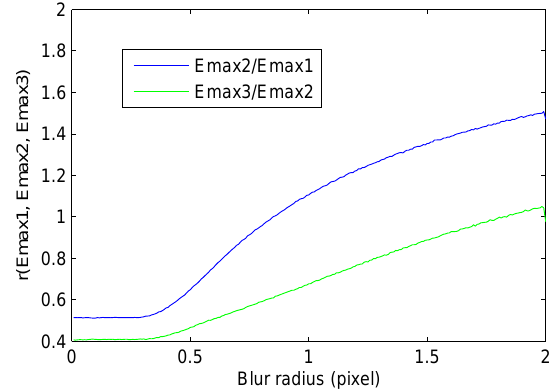
Figure 2: ¯ E max values for white noise images blurred by a Gaus- sian of increasing radius.